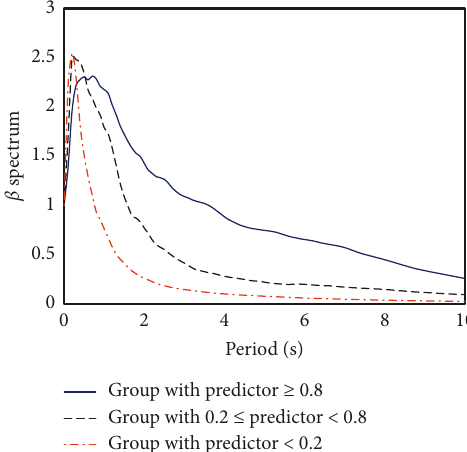
Figure 12: Mean normalized acceleration response spectra with respect to